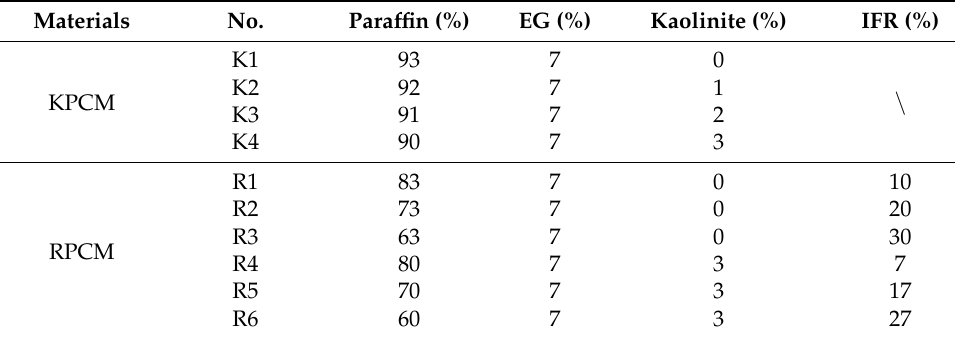
Figure 1. RPCMs preparation process. Table 1. Composition of RPCM.